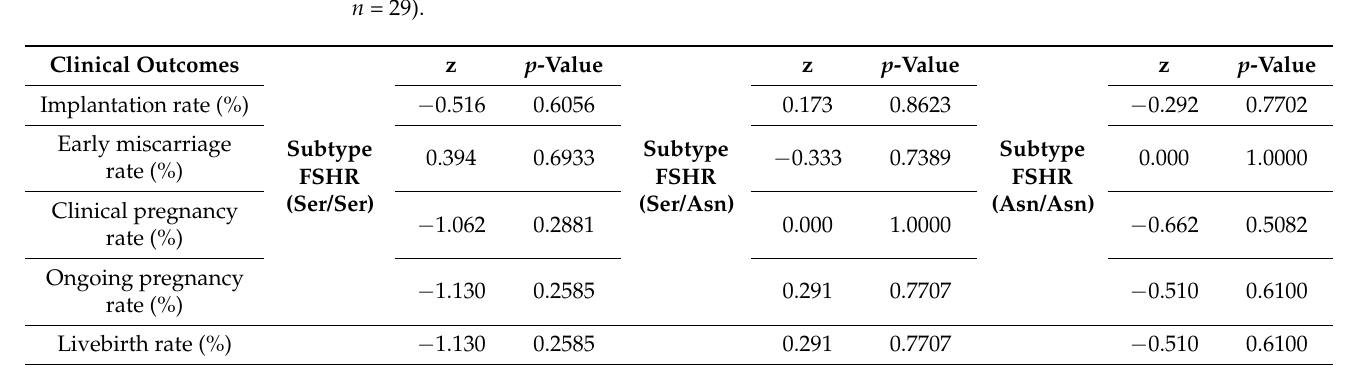
Table 4. Comparative analysis of clinical outcomes among study participants with three